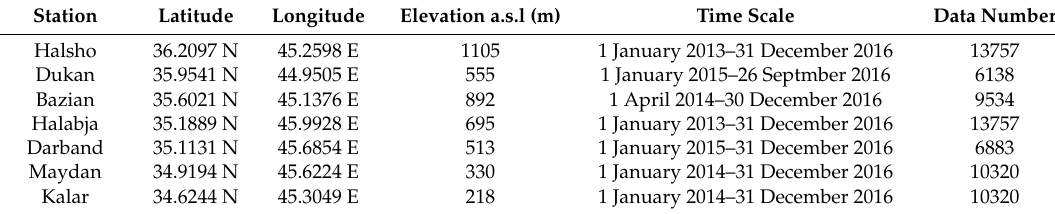
Table 2. Description of processed data of hourly global horizontal irradiance measured by a QMS101 Vaisala Pyranometer for the automatic stations.